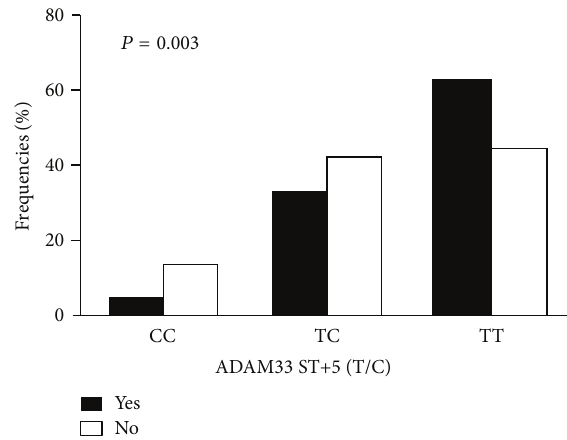
Figure 2: Environmental exposure modulates the association for ADAM33 ST+5 and asthma. x- axis represents ST+5 genotypes; 𝑦 - axis represents frequencies of genotype in individuals with (yes) or without (no) exposure to heavy